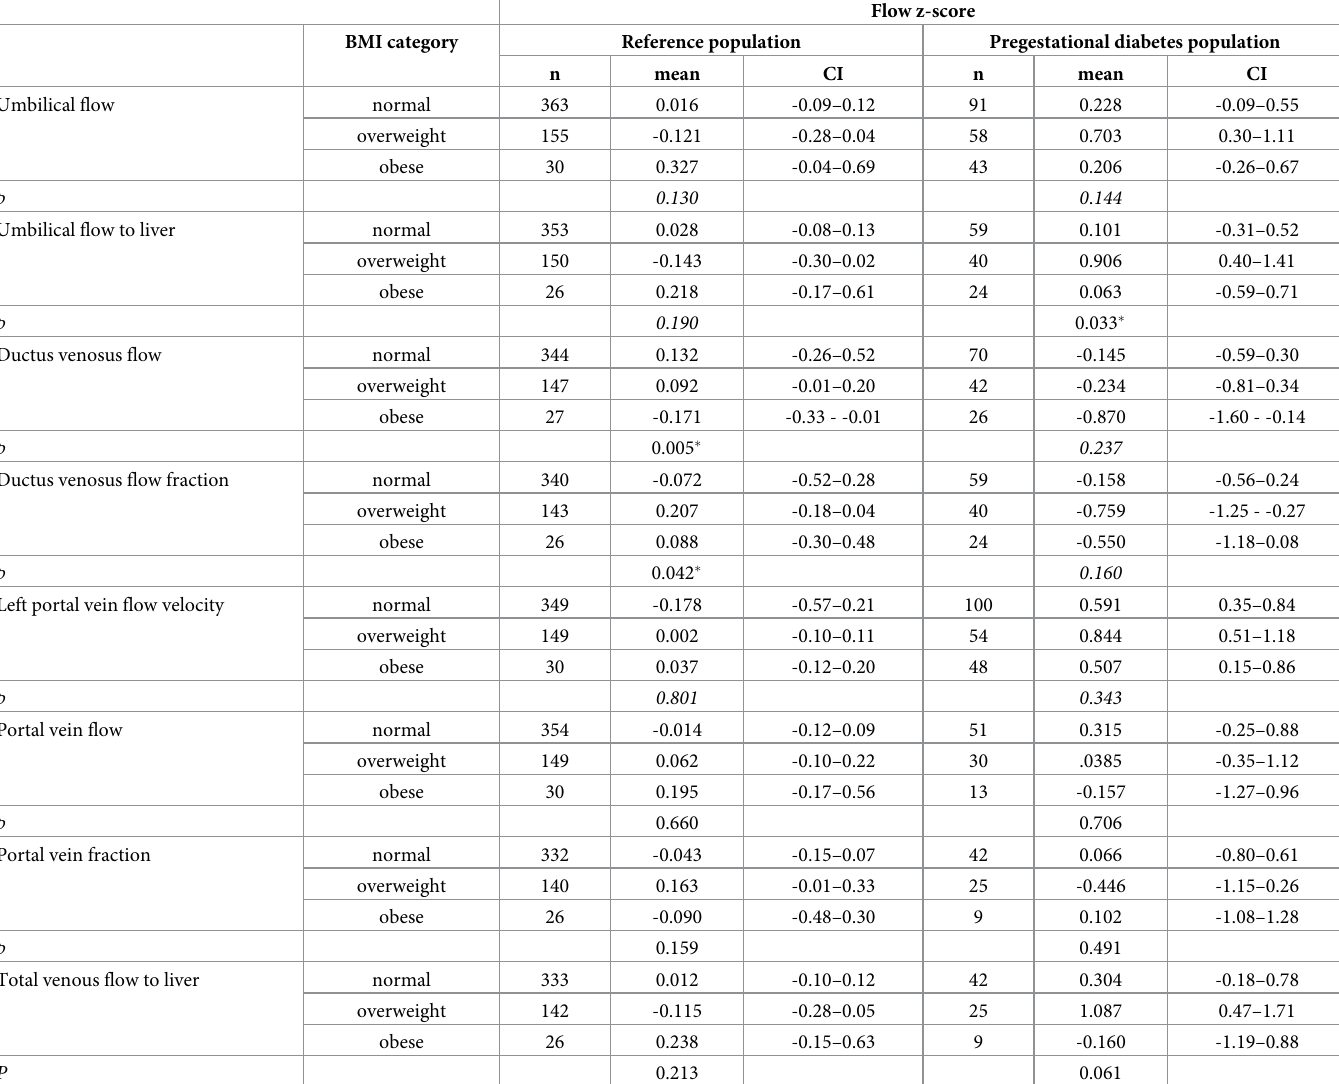
Table 5. Fetal venous liver flow according to pre-pregnancy BMI categories in the reference and pregestational diabetes mellitus populations (160 and 49 partici- pants,